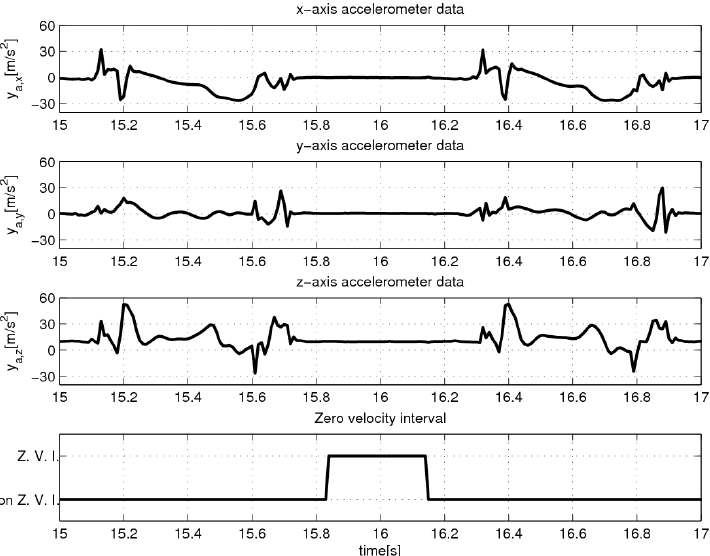
Figure 4. Accelerometer outputs and zero velocity interval.